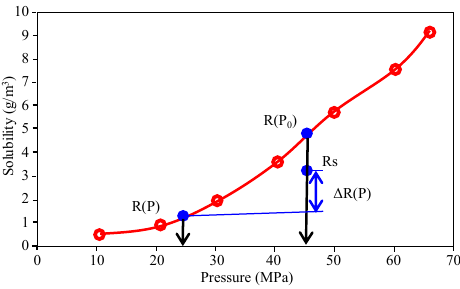
Figure 1. Sulfur solubility curve.